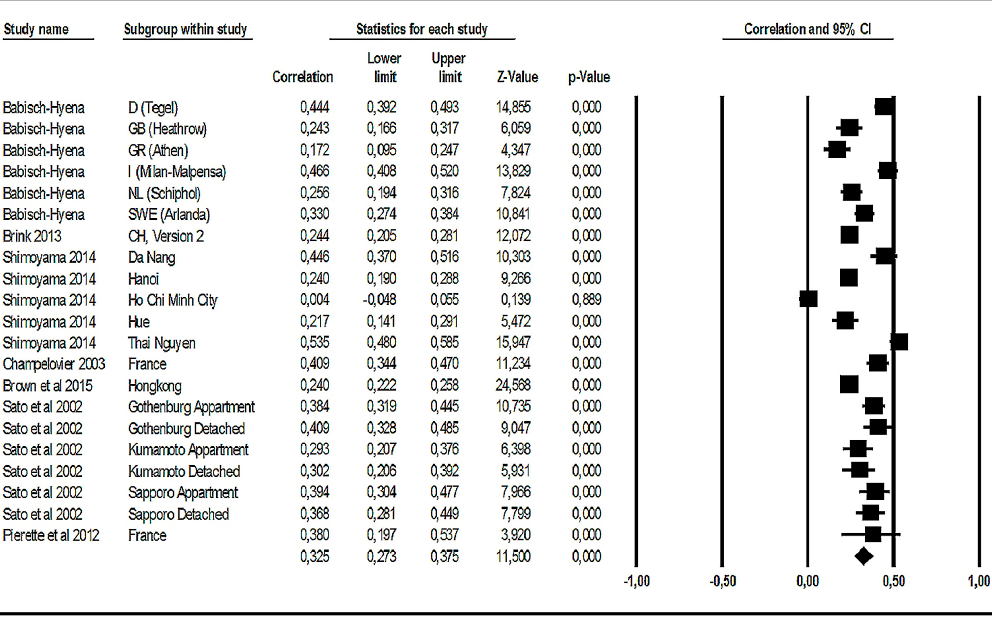
Figure 8. Meta ‐ analysis of 21 studies using Pearson correlations between L den or L dn and road traffic noise annoyance raw scores. The right part of the graph contains a forest plot of the correlations and their respective 95% confidence intervals. The figures of the last row indicate the summary estimates.